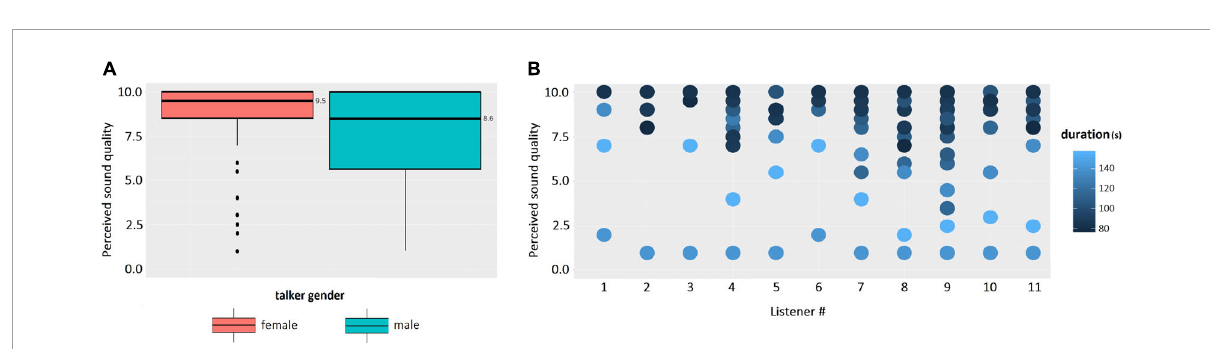
FIGURE5 (A) Perceived sound quality vs. talker gender. (B) Perceived sound quality vs. duration of the spoken passage across two talker